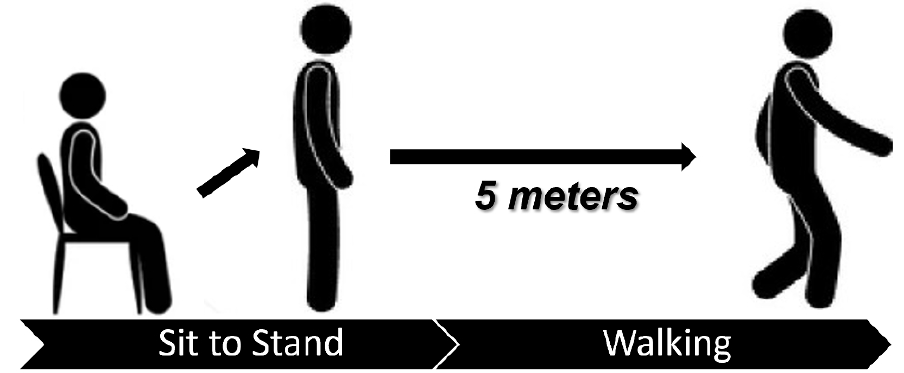
Figure 4. Sit-to-stand and gait speed